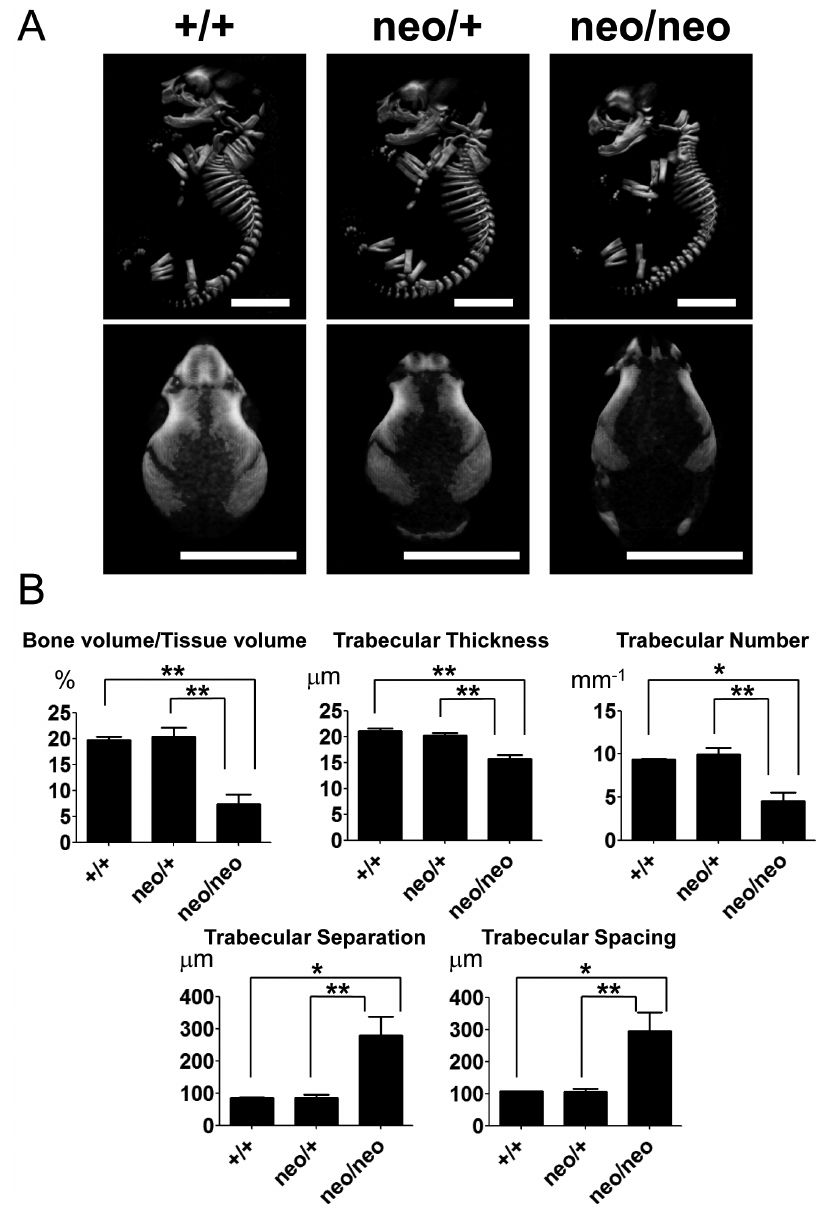
Figure 9. Runx2-I neo/neo mice showed decreased bone density. (A) Mineralization of E18.5 fetuses of wild-type ( + / + ), Runx2-I neo/ + (neo/ + ) and Runx2-I neo/neo (neo/neo) mice was assessed by microcomputed tomography of the whole body ( upper panels ) and the skull ( lower panels ). Scale bars: 5 mm. (B) Quantitative bone mineral parameters were calculated from femur measurements. All the parameters of Runx2-I neo/neo mice showed significantly severe deficiency of bone formation. Interestingly, Runx2-I neo/ + mice did not exhibit any abnormalities compared with wild-type littermates. Data are means 6 SEM ( n =4–9/group); * p , 0.05, ** p , 0.01. doi:10.1371/journal.pone.0108294.g009 (Fig. 3A and C). Because there were at least two types of Runx2 - neo fusion transcripts in Runx2-I neo/neo mice (Fig. 3D and 3E, middle panel ), it is possible that insertion of the neo cassette interfered with normal RNA splicing, as previously reported [15– 18]. The impaired expression of Runx2 in the Runx2-I neo/neo mice (Fig. 5B, left panels ) led to significant impairment of bone-related- gene expression (Fig. 7A and B) and fetal loss of bone ossification (Figs 8–10), resulting in neonatal lethality of homozygous mice, as previously reported for Runx2 -null mice [1,2].